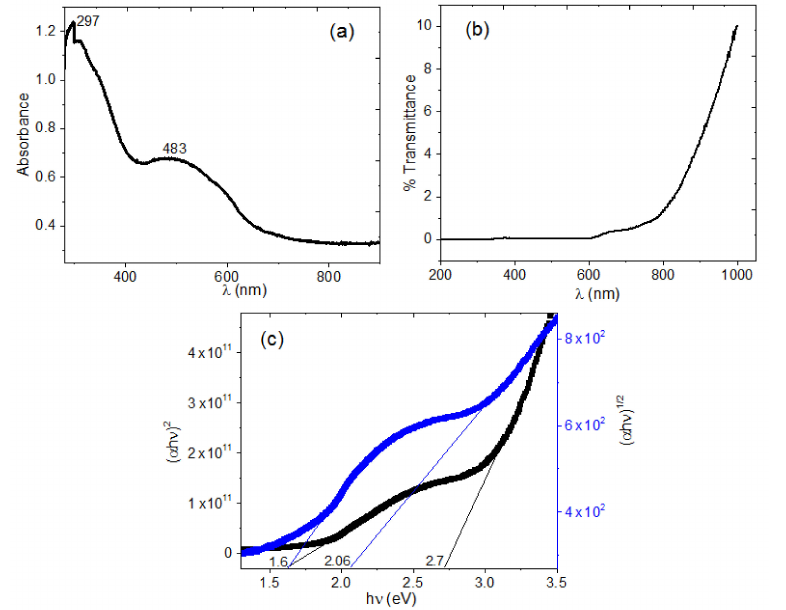
Figure 3. ( a ) Absorbance and ( b ) Transmittance spectrum. ( c ) Direct and indirect transitions for the pristine film of